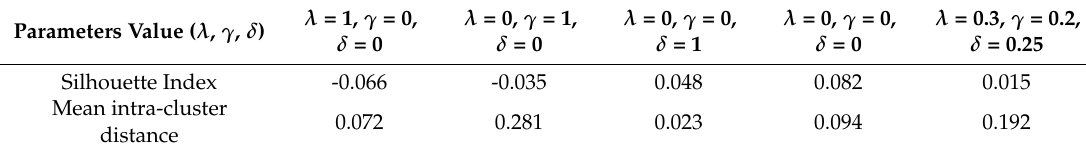
Table 2. Results of evaluation methods for automatic user grouping (database